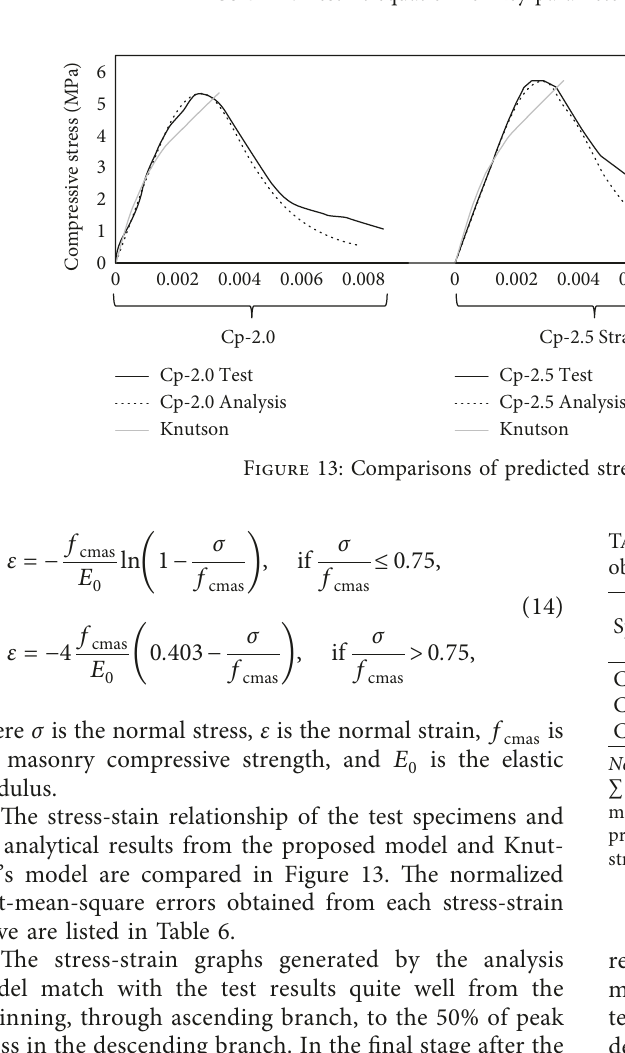
1 obtained from numerical analysis.